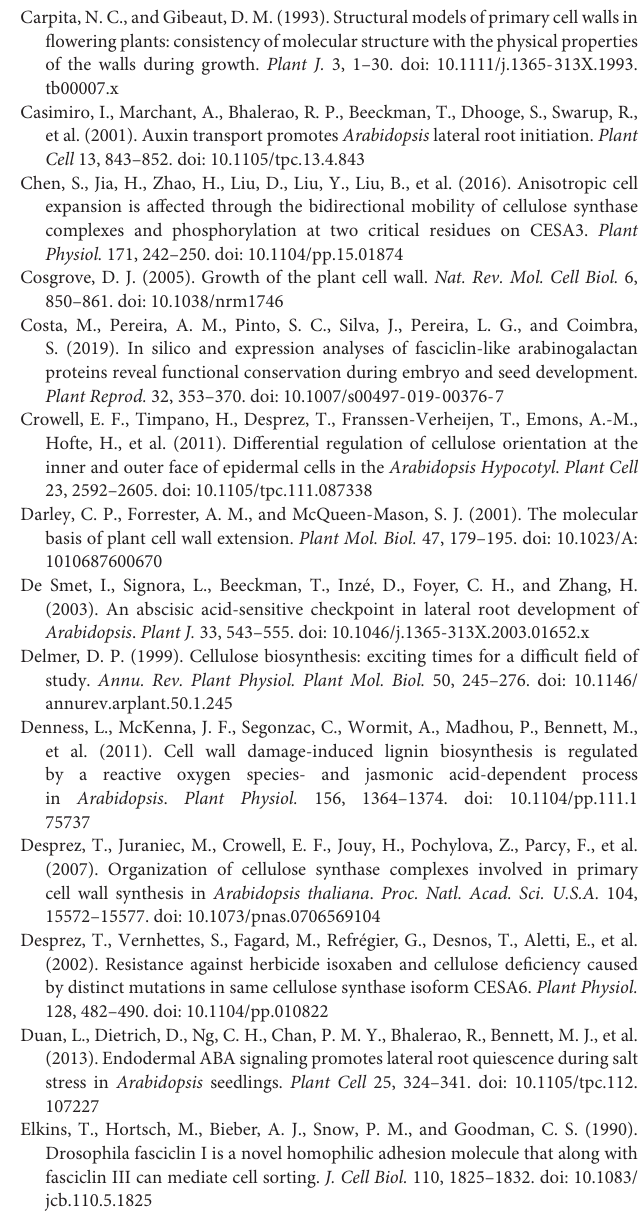
Supplementary Figure 4 | FLA18 gene expression in T-DNA insertion mutants, as compared to wild type. Supplementary Figure 5 | Primary root elongation in fla18 mutants. Supplementary Figure 6 | Lateral root length measurements for quantification. Supplementary Figure 7 | Expression of FLA18 suppresses the short and swollen lateral root phenotype of fla18-1. Supplementary Figure 8 | Primary root length of fla18-1sos5. Supplementary Figure 9 | The fla18sos5 double mutant phenotype on media containing 1% sucrose. Supplementary Figure 10 | FLA18 and SOS5 gene expression in fla18-1, sos5 and the double mutant fla18-1sos5.